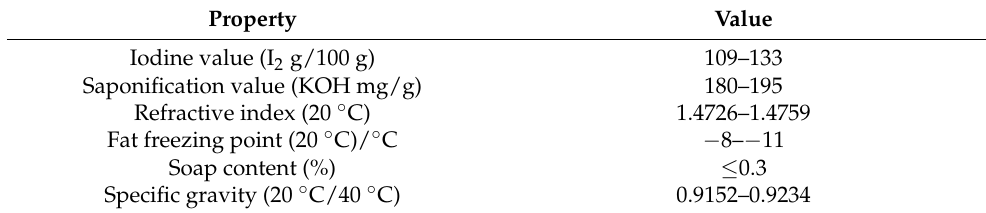
Table 3. Physical and chemical properties of corn germ oil